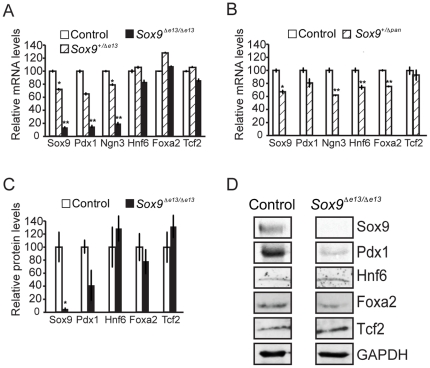
Sox9 regulates Pdx1 mRNA and protein expression.Quantitative RT-PCR of pancreata from Sox9flox/fox or Sox9+/fox embryos injected with tamoxifen at e12.5 and analyzed at e15.5 (Sox9Δe13/Δe13 or Sox9+/Δe13) (A; n = 9) shows reduced levels of Pdx1 and Ngn3, but not of Hnf6, FoxA2, or Tcf2. In Sox9+/Δpan pancreata after Pdx1-Cre-mediated recombination of one Sox9-flox allele (B; n = 9), Pdx1, Ngn3, Hnf6, and FoxA2 mRNA levels are reduced at e15.5. Western Blot analysis (C, D; n = 4) shows diminished Pdx1 expression, but not Hnf6, Foxa2, or Tcf2 expression in pancreata from Sox9Δe13/Δe13 embryos at e15.5. Values are shown as mean ± S.E.M.; * = P<0.05; ** = P<0.01.